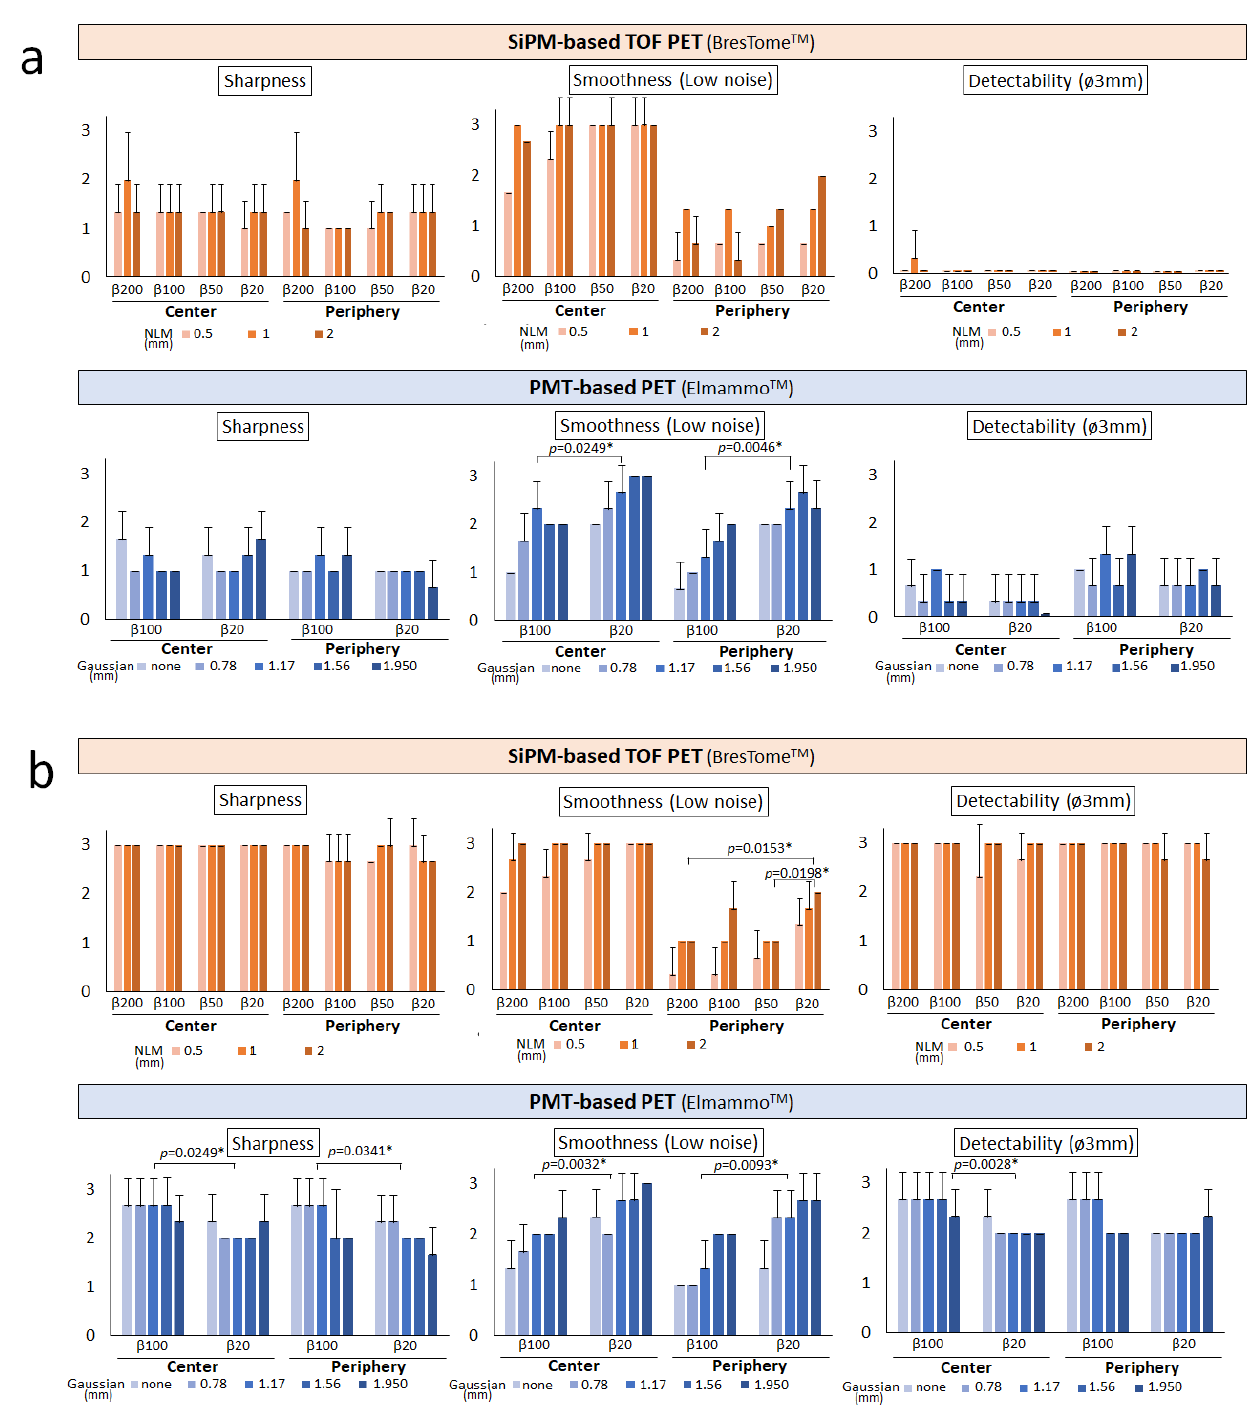
Figure 5. Averaged scores of the visual assessment of breast phantom images obtained with the two organ-specific PET scanners reconstructed with different β -values and post-filters. The sphere-to- background ratios were 4:1 ( a ) and 8:1 ( b ). Top: SiPM-based TOF-PET (BresTome™) images. Bottom: PMT-based PET (Elmammo™) images. * Statistically significant.